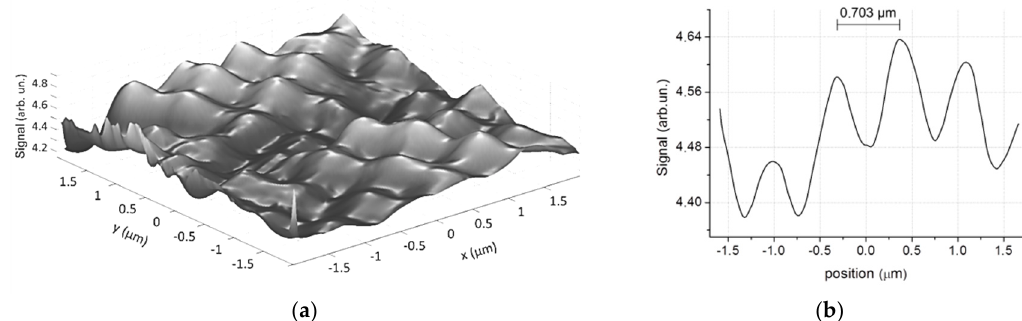
Figure 4. ( a ) Image of the near field of LED patterned with 2D PhC structure and ( b ) corresponding NSOM line profile across the structure.